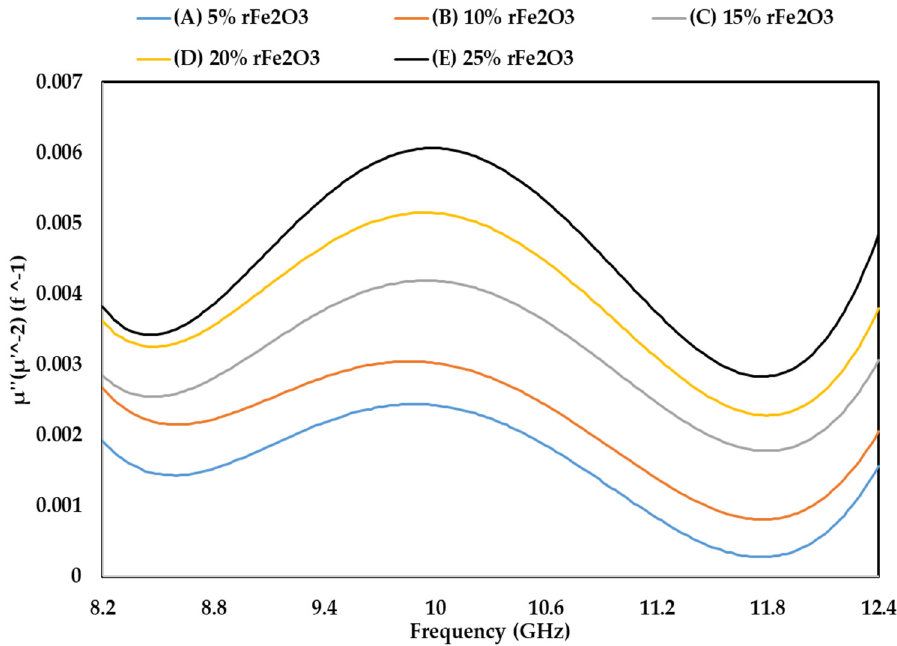
Figure 17. The values of (cid:2020) (cid:4593) (cid:4666)(cid:2020)′′) (cid:2870) (cid:1858) (cid:2879)(cid:2869) as a function of frequency for rFe 2 O 3 –PTFE nanocomposites.